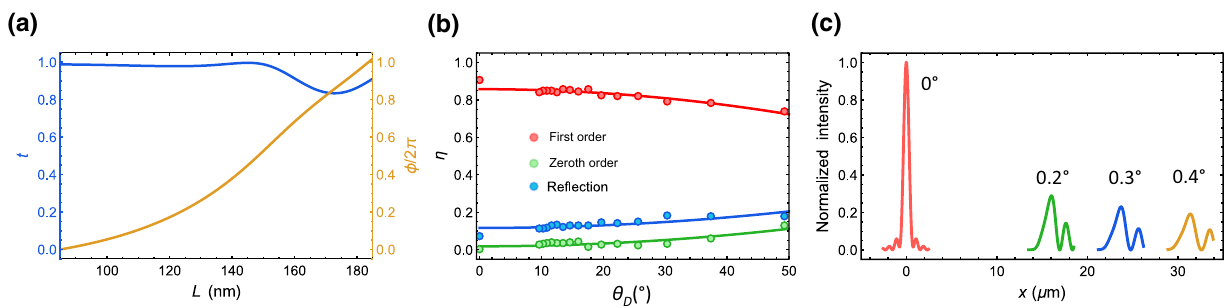
FIG. 4. The metalens design and simulations. (a) The transmittance t and phase shift φ as a function of the nanopillar side length L . (b) The calculated deflection efficiency η 1 , the fraction of light in the undeflected zeroth-order η 0 , and the reflectance η refl of aperiodic metasurface beam deflectors as a function of the deflection angle θ D . The circles are data from RCWA simulations and the solid lines are parabolic fits. (c) The FDTD simulated beam profiles of the focal spots as a function of the angle of the incident